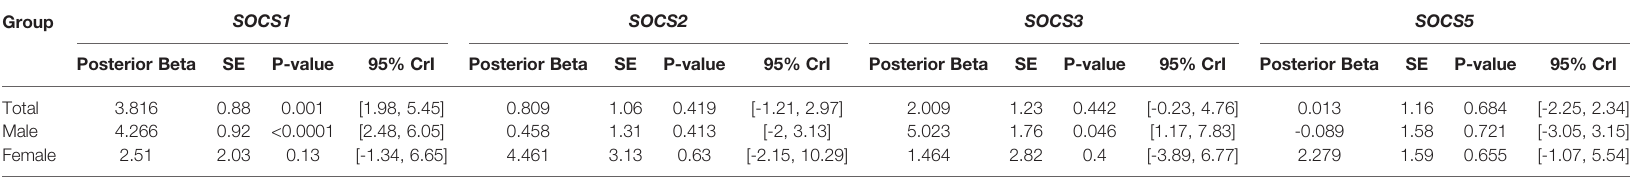
TABLE 4 | Relative expression of SOCS genes in AIPD cases versus CIDP cases.